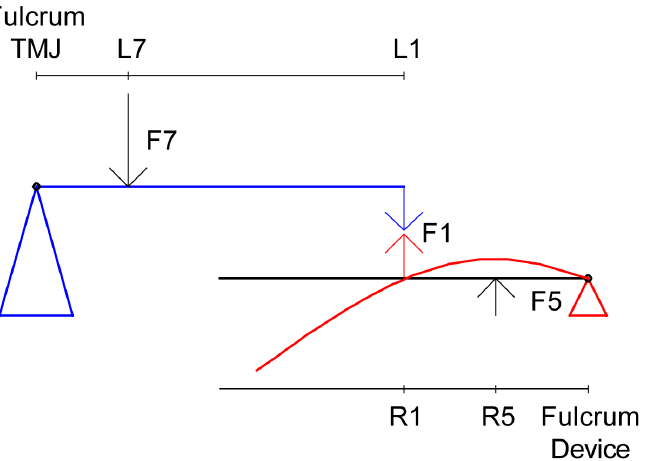
Figure A7. Representation of the single deformation acting only on the upper device fork plate.